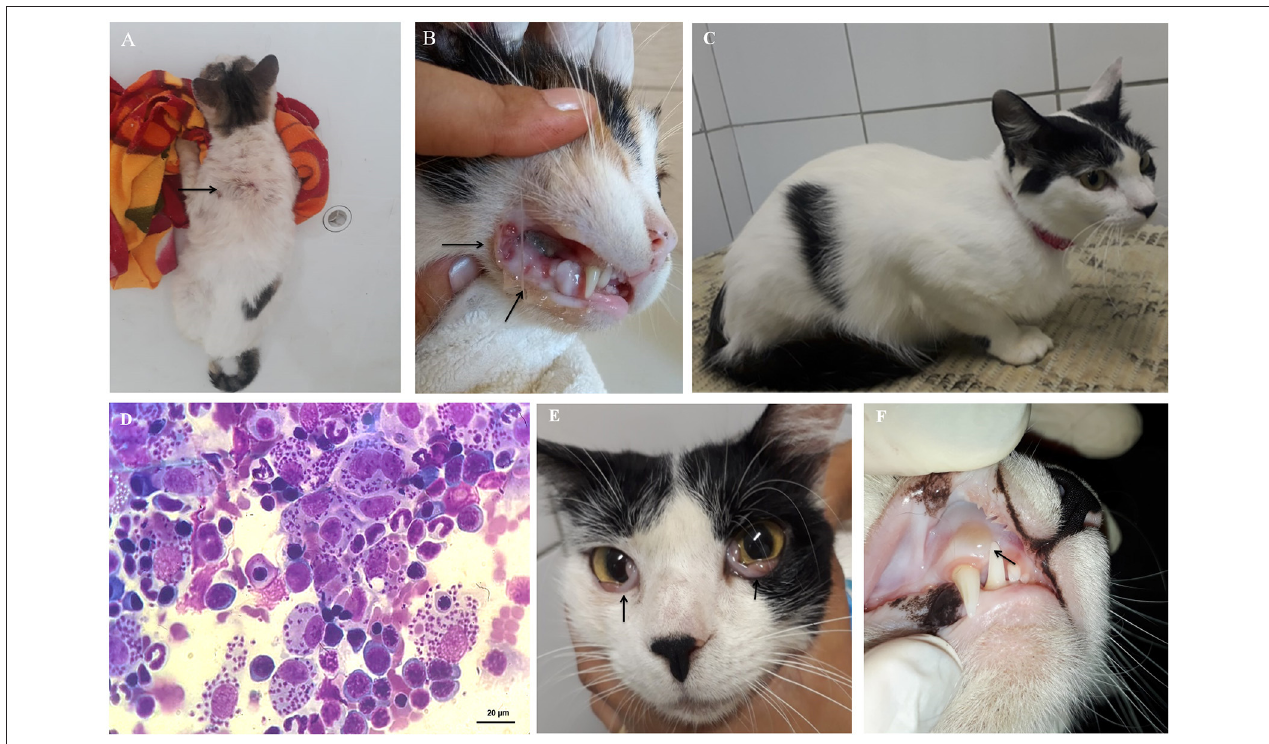
FIGURE 3 | Clinical signs of feline leishmaniasis. (A) Areas of alopecia in the dorsal cervical region (arrow), and (B) ulcers in the oral cavity, suggesting gingivitis-stomatitis complex (arrows). (C) First physical exam of a cat with active infection without clinical signs but presenting Leishmania detection in bone marrow aspirates by cytological examination (D) . After 4 months, this cat had (E) bilateral oedema and hyperaemia of the conjunctiva (arrows) and (F) aphthous stomatitis in the upper region of the right canine tooth